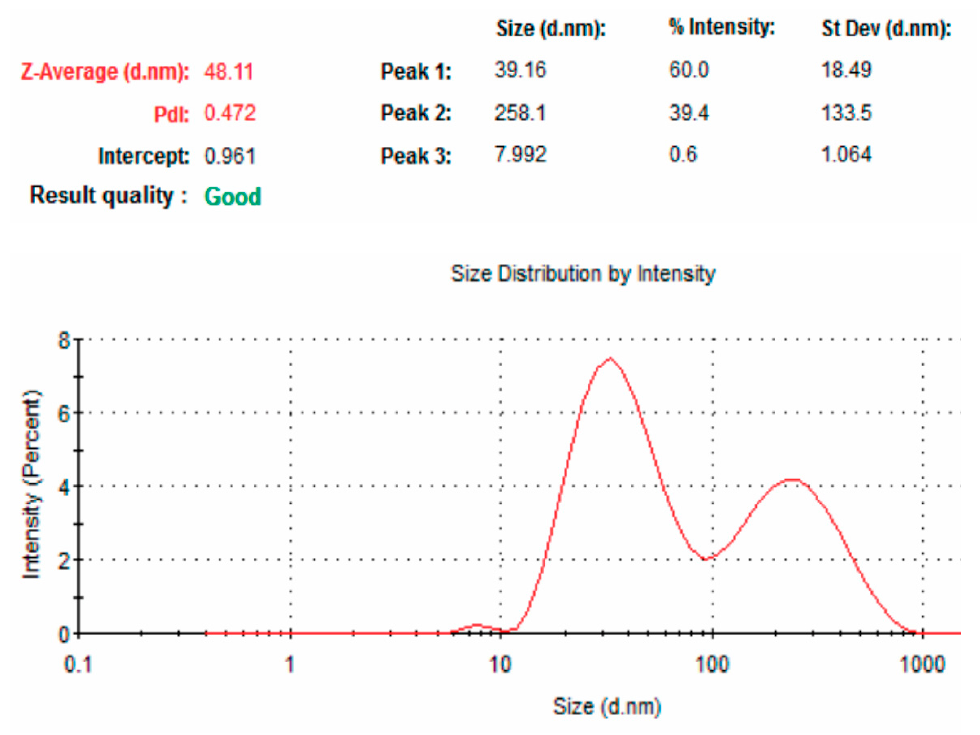
Figure 2. Size distribution of AgNPs-RR using dynamic light scattering (DLS) .